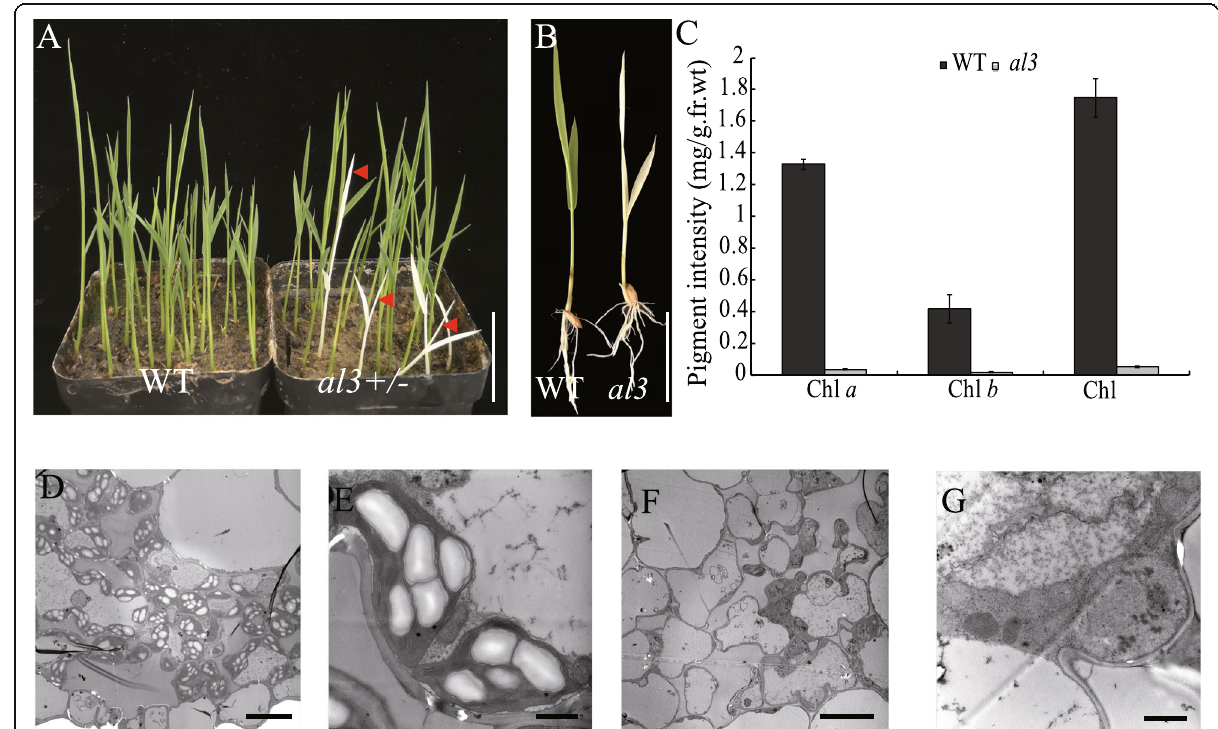
Fig. 1 Phenotypes of the wild-type and the al3 mutant. a , b Leaf color of the 7-day-old wild-type and al3 seedlings. Bars = 5 cm. c Chlorophyll contents of 7-day-old wild-type and al3 seedlings. d , e Chloroplast ultrastructure in the wild type mesophyll cell. f , g Chloroplast ultrastructure in al3 mesophyll cell. Bars = 10 μ m for ( d ) and ( f ); 1 μ m for ( e ) and ( g